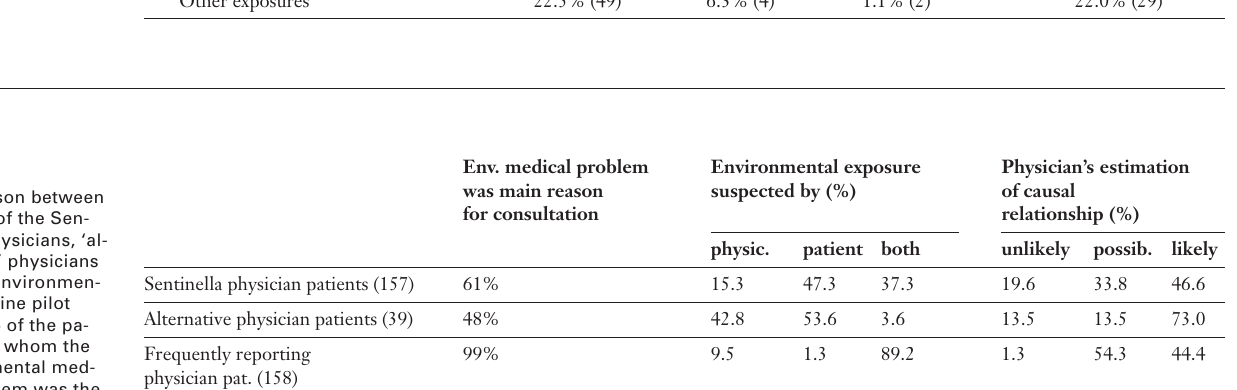
Comparison between patients of the Sen- tinella physicians, ‘al- ternative’ physicians and the environmen- tal medicine pilot project: 5 of the pa- tients for whom the environmental med- ical problem was the main reason for con- sultation, person who suspected environ- mental exposure and physicians” estimate of a likelihood of a relationship between the exposure and the health